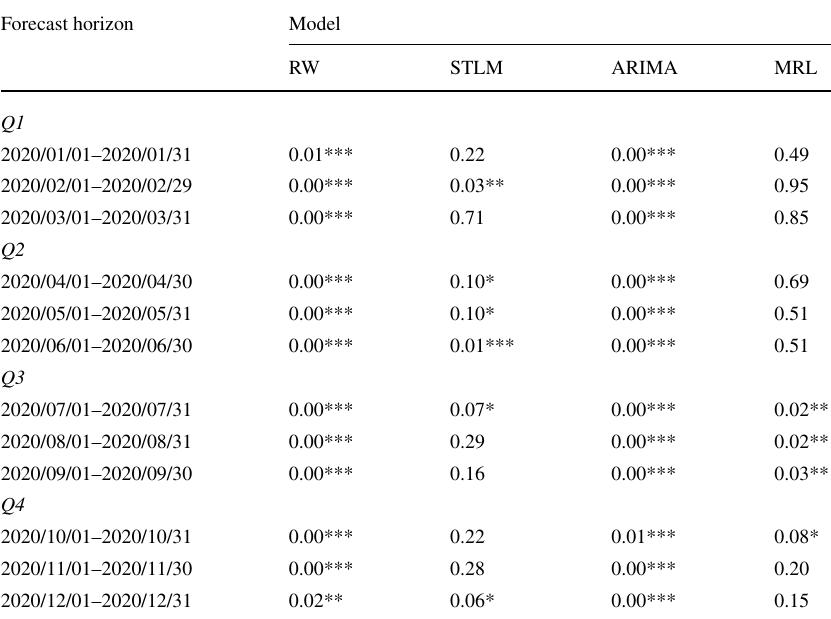
Table 5 Diebold-Mariano test Forecast